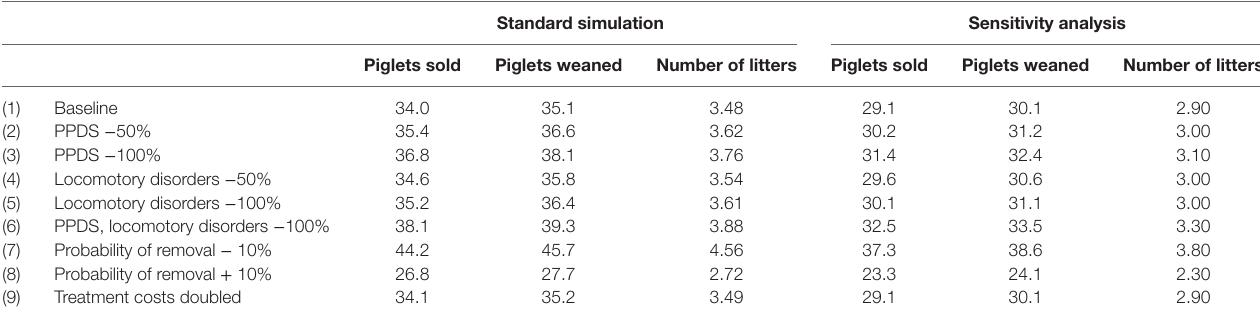
Table 5 | Lifetime piglet yield (number of weaned piglets and sold piglets) per sow, and expected number of litters produced per sow, according to the dynamic programming model for the analyzed standard simulation scenarios and sensitivity analysis scenarios.